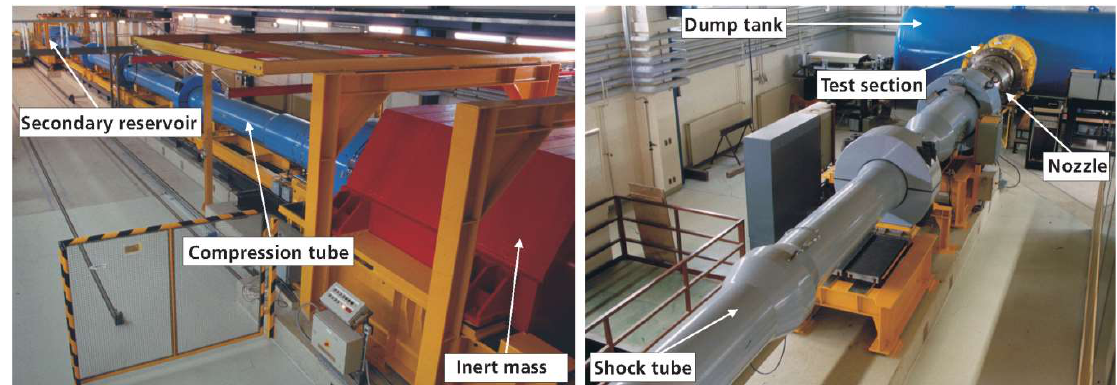
Figure 3: Photographic views of the High Enthalpy Shock Tunnel Göttingen,